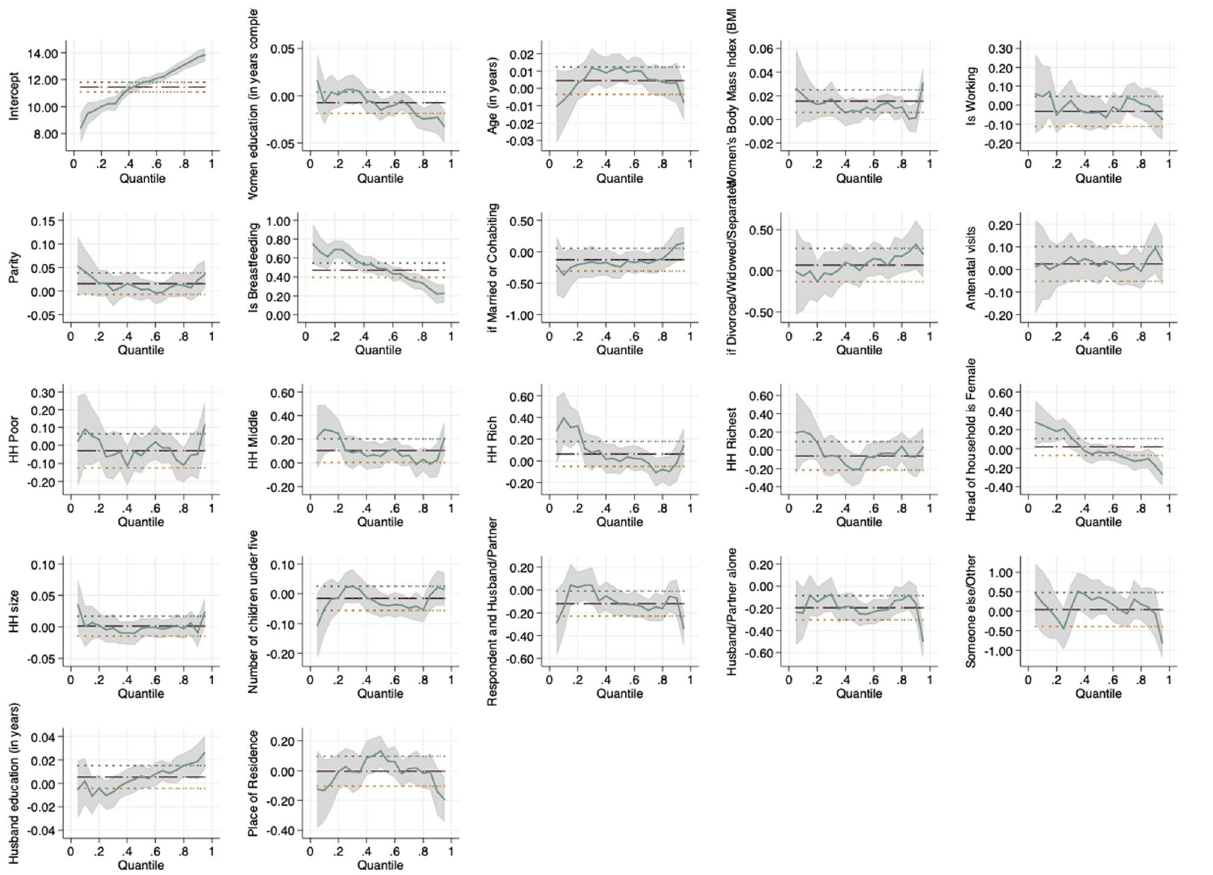
Figure 2. Pictorial presentation of the effects of socio-demographic factors on maternal Hb concentration in